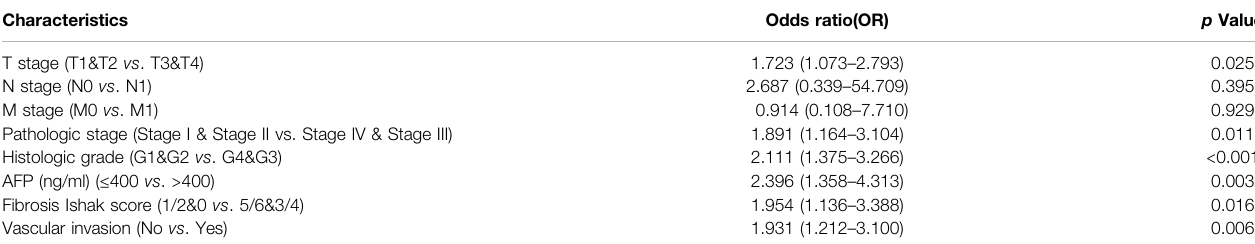
TABLE 1 | Logistic regression analysis of association between clinicopathological characteristics and PRPF19 expression in LIHC patients. Characteristics Odds ratio(OR) p